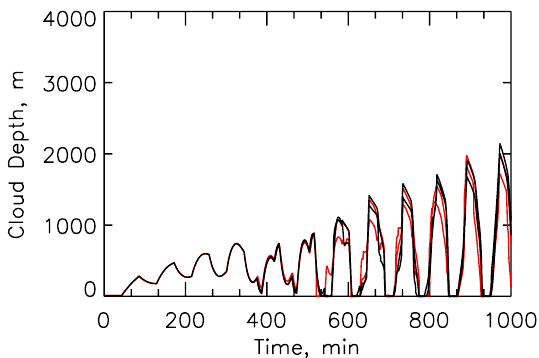
Fig. 6. One-dimensional solution to the equations for I = 21, τ c = 43min (2 × T ), and η = − 0 . 63. Red lines: i = 5 and i = 7; black lines: i = 6 and i = 8. All clouds are synchronized over the duration of the simulation.